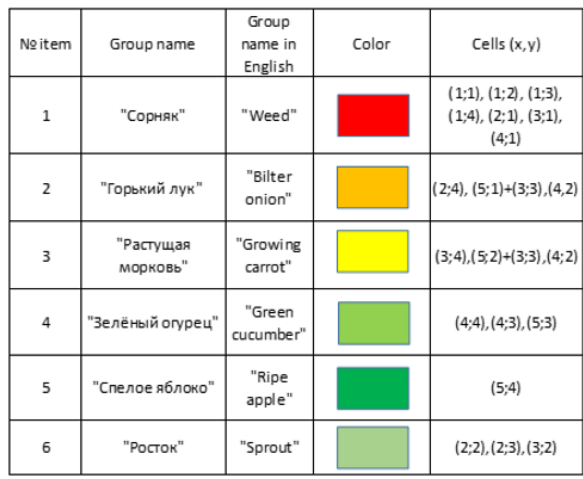
Fig. 6. Levels of competence